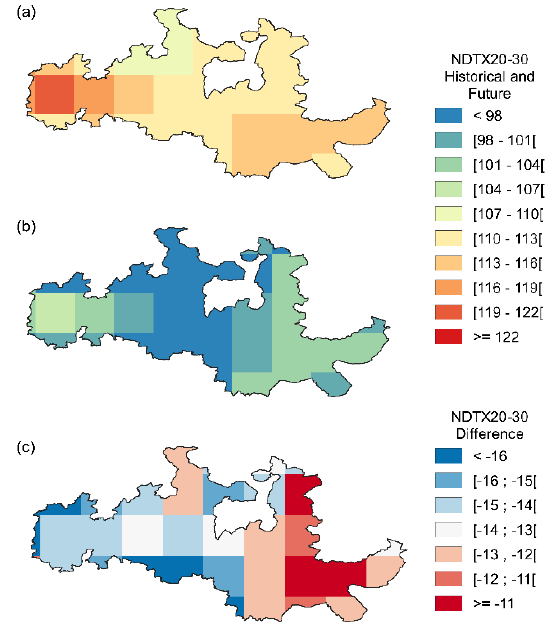
Figure 8. Ensemble-mean of the Number of Days with maximum temperature between 20 and 30 ◦ C (NDTX20-30) for the Douro Wine Region, bias-corrected by quantile mapping, for the ( a ) historical (1989–2005), ( b ) future (2051–2080) under the RCP8.5, and ( c ) future historical difference.